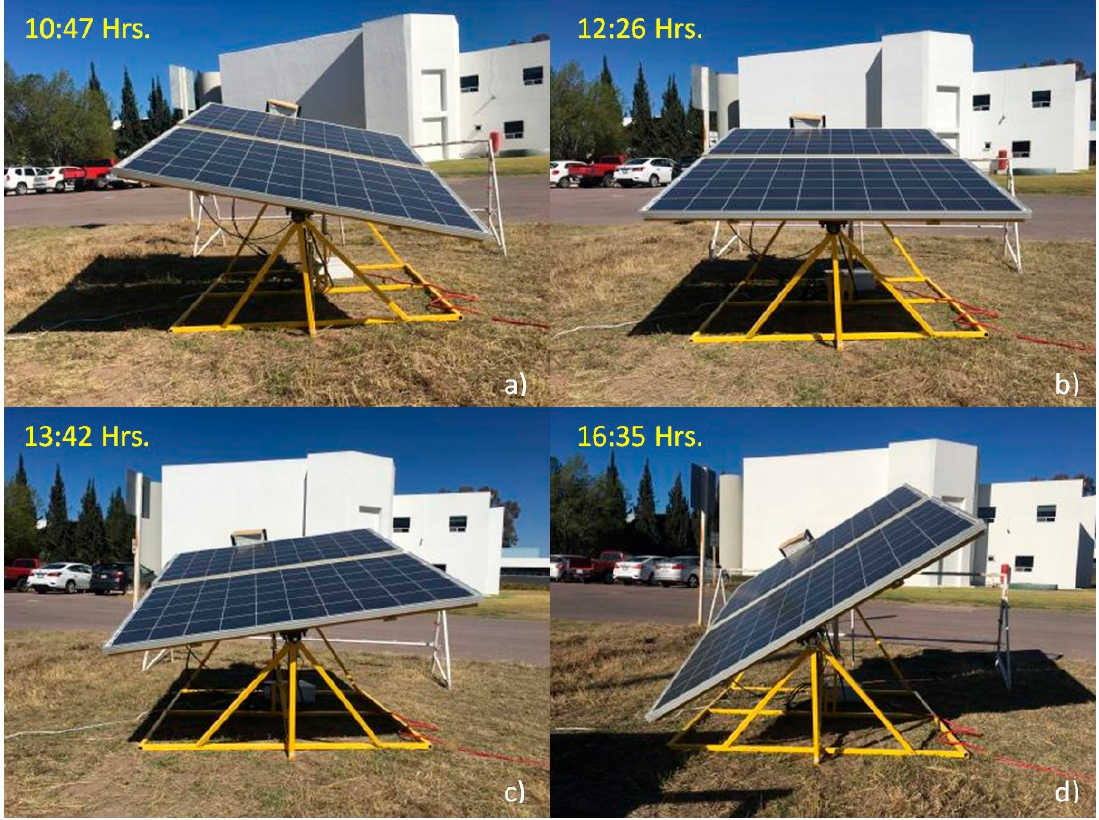
Figure 12. Movement of the solar tracker over a day. Morning position ( a ), noon position ( b ), afternoon position ( c ) and ( d ).